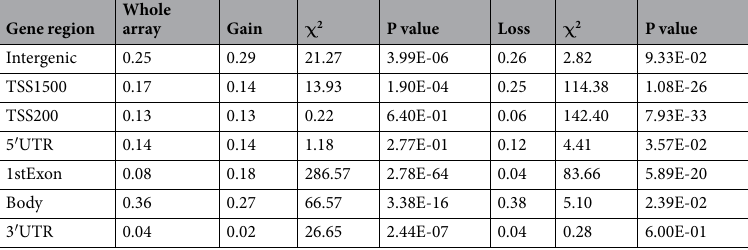
Table 1. Proportionality of gene regions for all CpGs of the array and in age-methylated (gain) and demethylated (loss) CpGs.